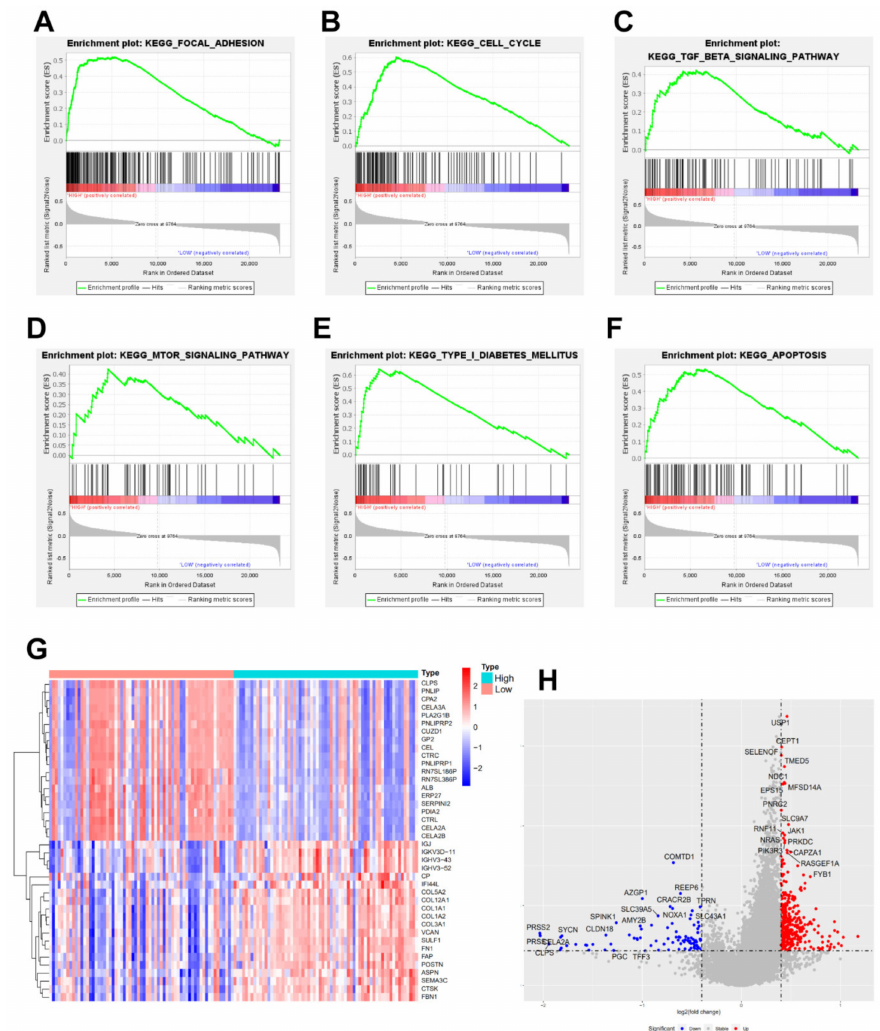
Figure 4. Gene set enrichment analysis (GSEA) of NRDC, ( A – F ) different signal pathway enrichment of NRDC, curves marked with green flag mean gene enrichment. Peaks on the upward curve indicate positive correlation. ( G ) according to the average expression of NRDC, divided genes into high and low groups, heatmap of the top 40 differentially expressed genes in the analysis result (Red: up-regulation; Blue: down-regulation), ( H ) divided the expression of NRDC into high and low groups, volcano plot of differential genes were expressed (logFC ≥ 0.4 and − log10 (adj. p Value) ≥ 1 were defined as significance. Red: up-regulation; Blue: